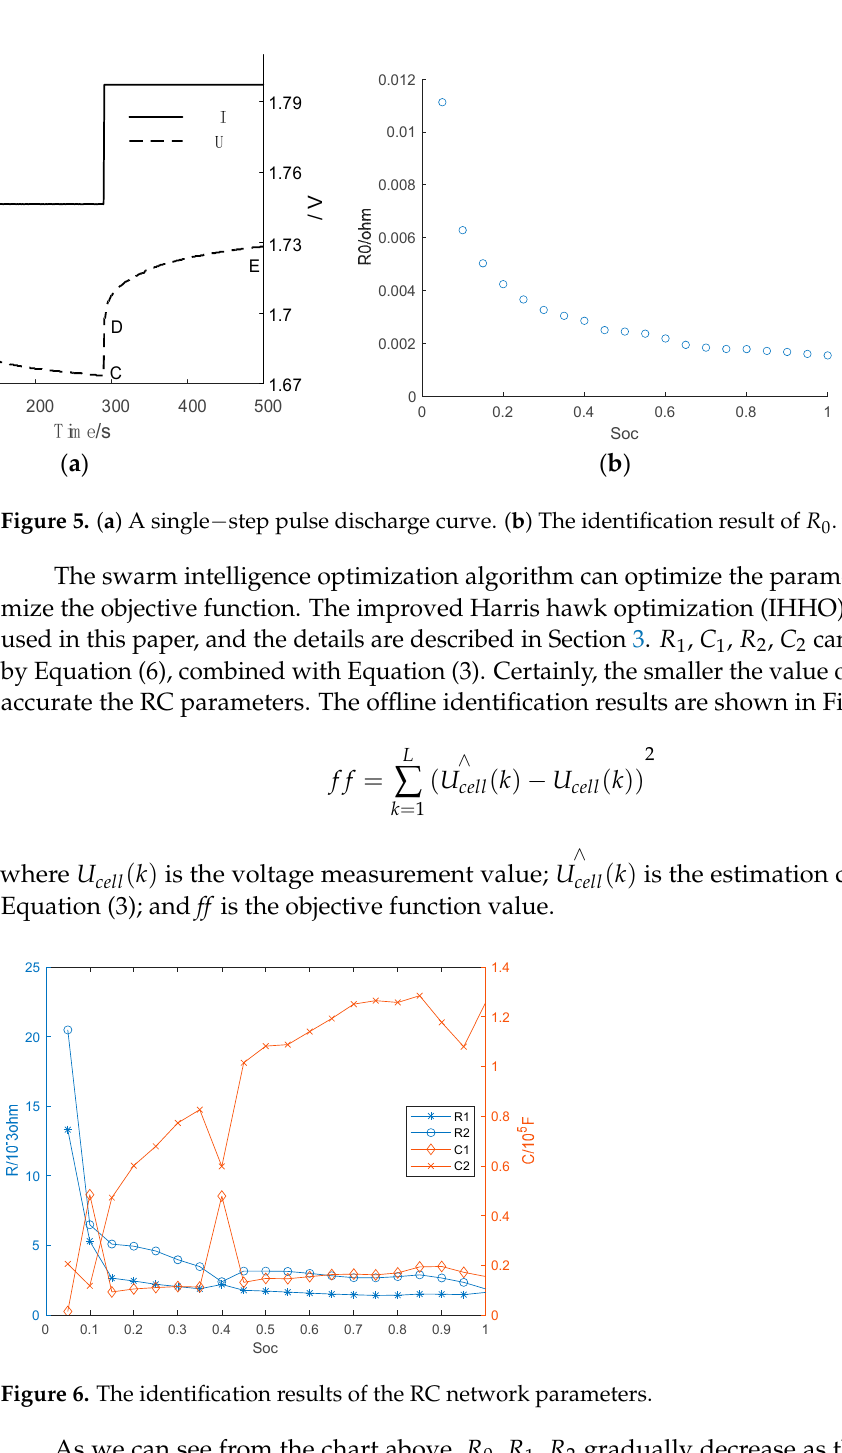
Figure 6. The identification results of the RC network